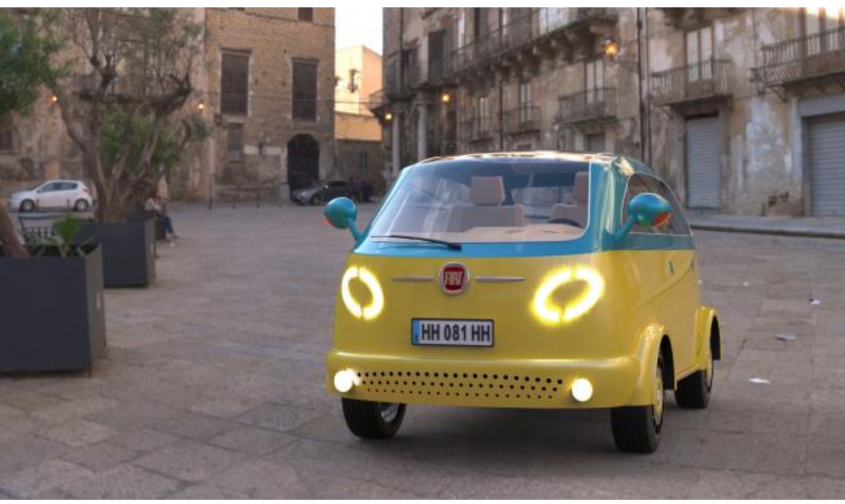
Figure 33. New FIAT 600 Omega—Rendering: City environment.